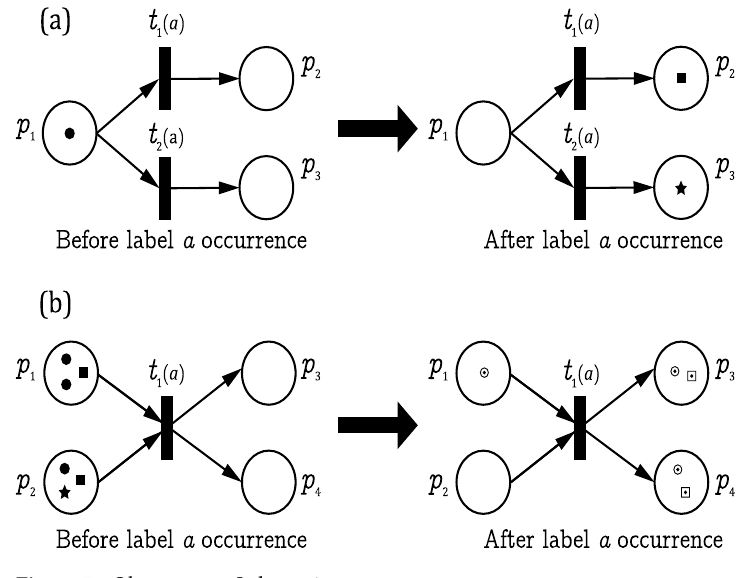
Figure 7. Observer net (cid:31) dynamics.